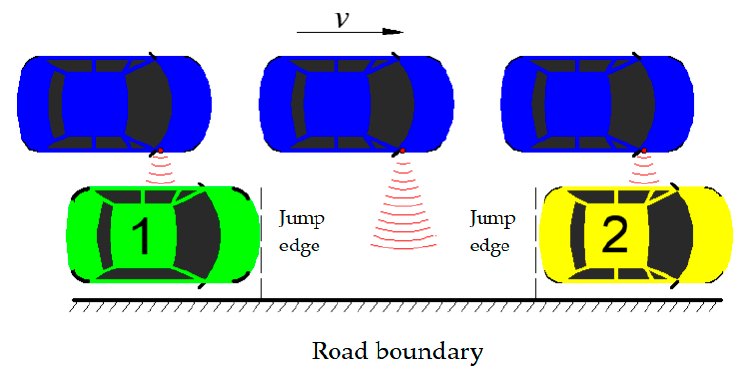
Figure 7. The detection process of the size of parking